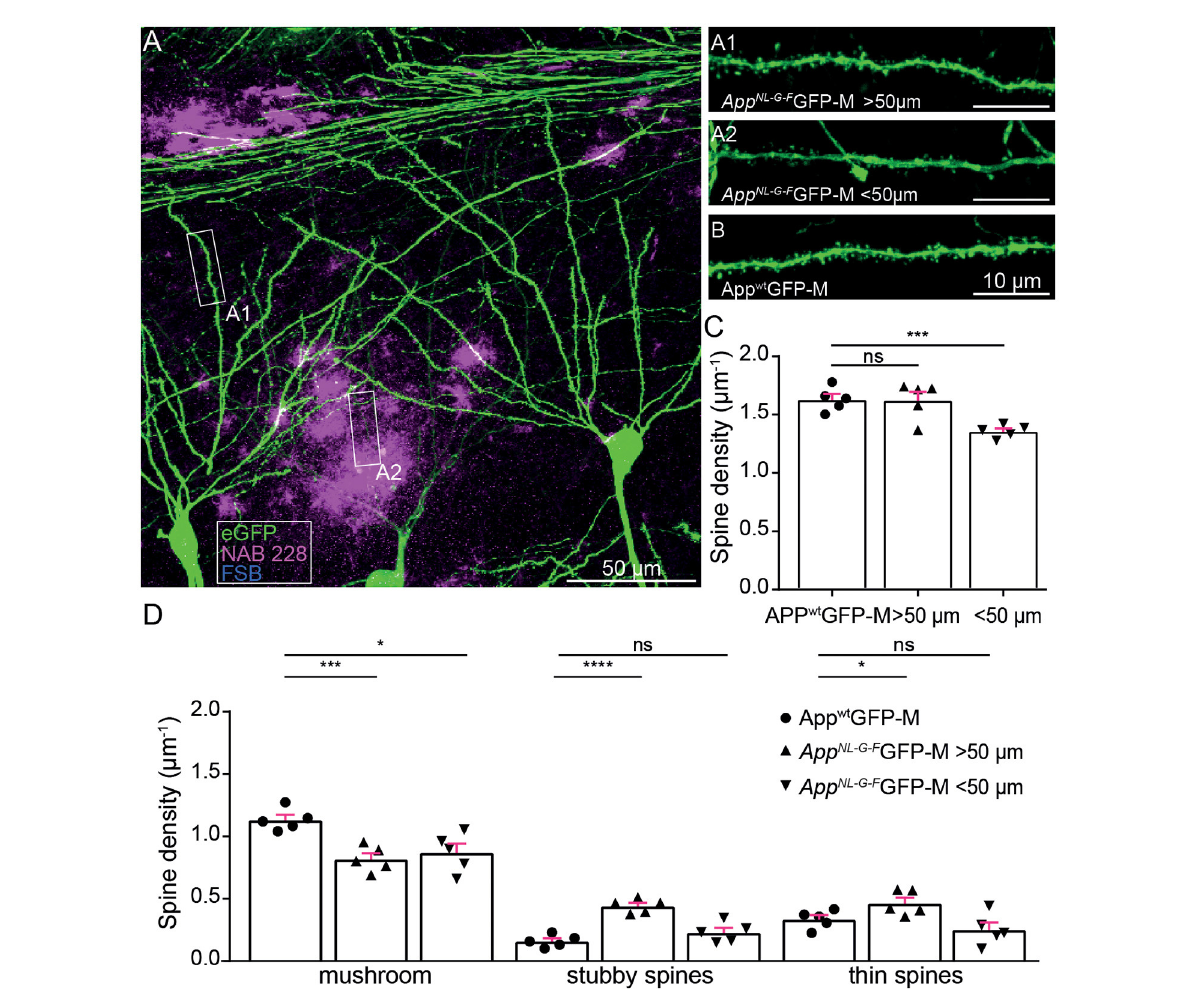
FIGURE1 Ex vivo spine analysis showed a decrease in mushroom spines but not in total spine density distant to A β -depositions in App NL − G − F mice. (A) The overview picture of a section in the stratum oriens CA1 subfield of the hippocampus is shown as a maximum intensity projection. eGFP expression (green), oligomeric A β (NAB228, magenta), fibrillar A β (FSB, cyan). (A1,A2) High-resolution confocal images of second-degree branched dendrites distant ( > 50 µ m) and proximal ( < 50 µ m) to A β -depositions of App NL − G − F GFP-M mice as well as in App wt GFP-M animals (B) are shown as maximum intensity projections. (C,D) Density of total, mushroom, thin and stubby spines of App wt GFP-M mice and App NL − G − F GFP-M mice distant ( > 50 µ m) and proximal ( < 50 µ m) to A β -depositions. N = 5 male mice, n = 7–10 dendrites. Data are presented as mean ± SEM. Two-sample Student’s t -test results: * p < 0.05, *** p < 0.001, **** p <